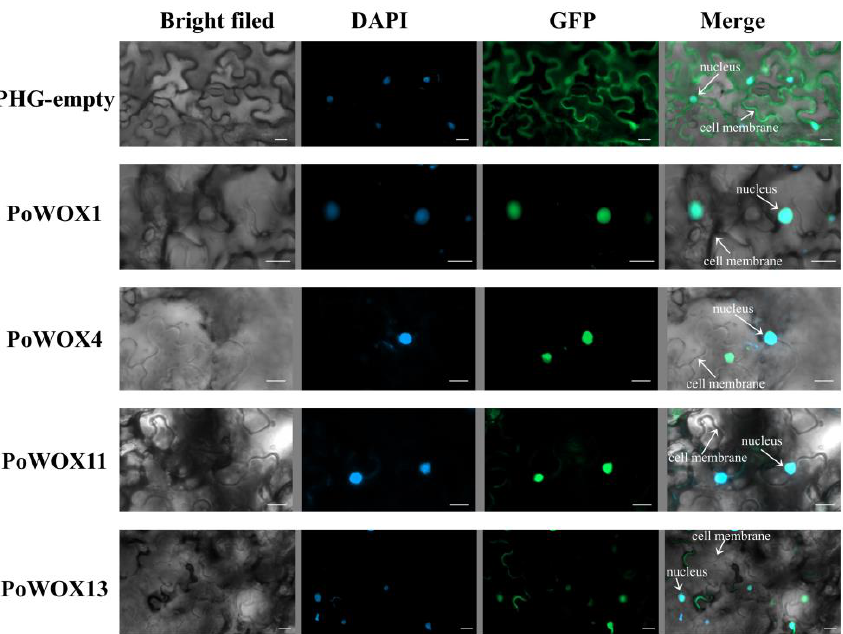
Figure 6. Subcellular localization analysis of 35::PoWOX-GFP fusion proteins. The 35::PoWOX-GFP vector was infected with N. benthamiana mediated by Agrobacterium GV3101, and the expression of the fusion protein was observed under the Zeiss Axio Imager M2 microscope. Positive control 35S::GFP fusion protein was expressed in the nucleus and cytoplasm, and PoWOX protein was expressed in the nucleus. Tobacco leaf cells were stained. Green fluorescence shows the fusion protein location and blue fluorescence is the nuclear signal localized by DAPI for bright field, DAPI, GFP, and merge, respectively. Positive control is 35S::GFP empty. The white arrows indicate the location of the nucleus and the cell membrane. The scale bar is 20 μm.